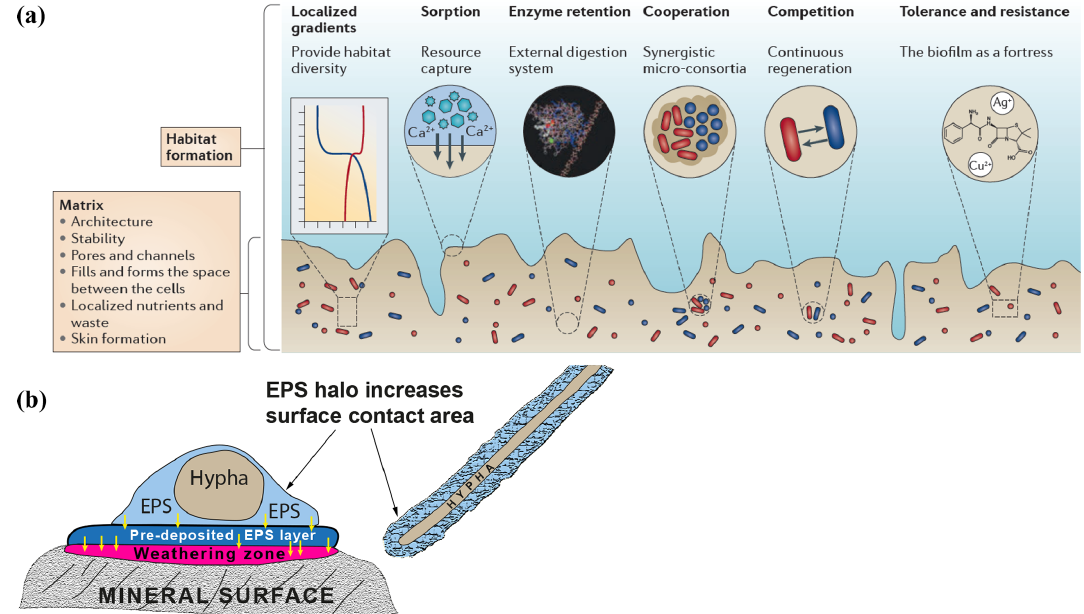
Figure 1. (a) Schematic diagram showing biofilm structure and function and the biological and chemical processes that biofilms influence. (b) Extracellular polymeric substance (EPS) halos and their possible influence on interactions between hypha and mineral surfaces (based on observations by Gazzè et al., 2013). (Figure 1a is reproduced with permission from Flemming et al.,